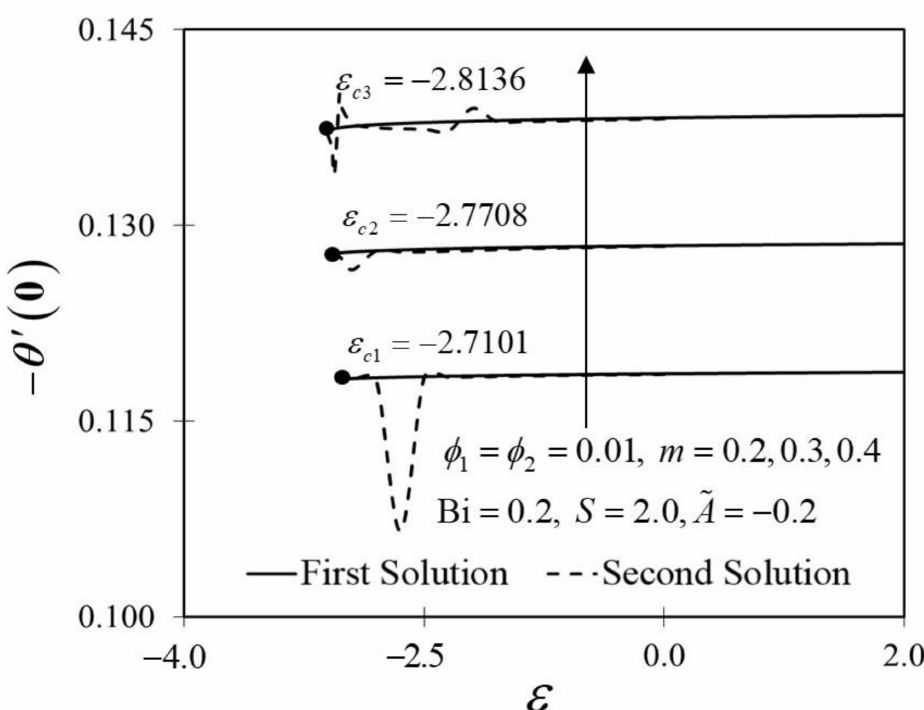
Figure 7. Trend of − θ (cid:48) ( 0 ) with ε and assorted m